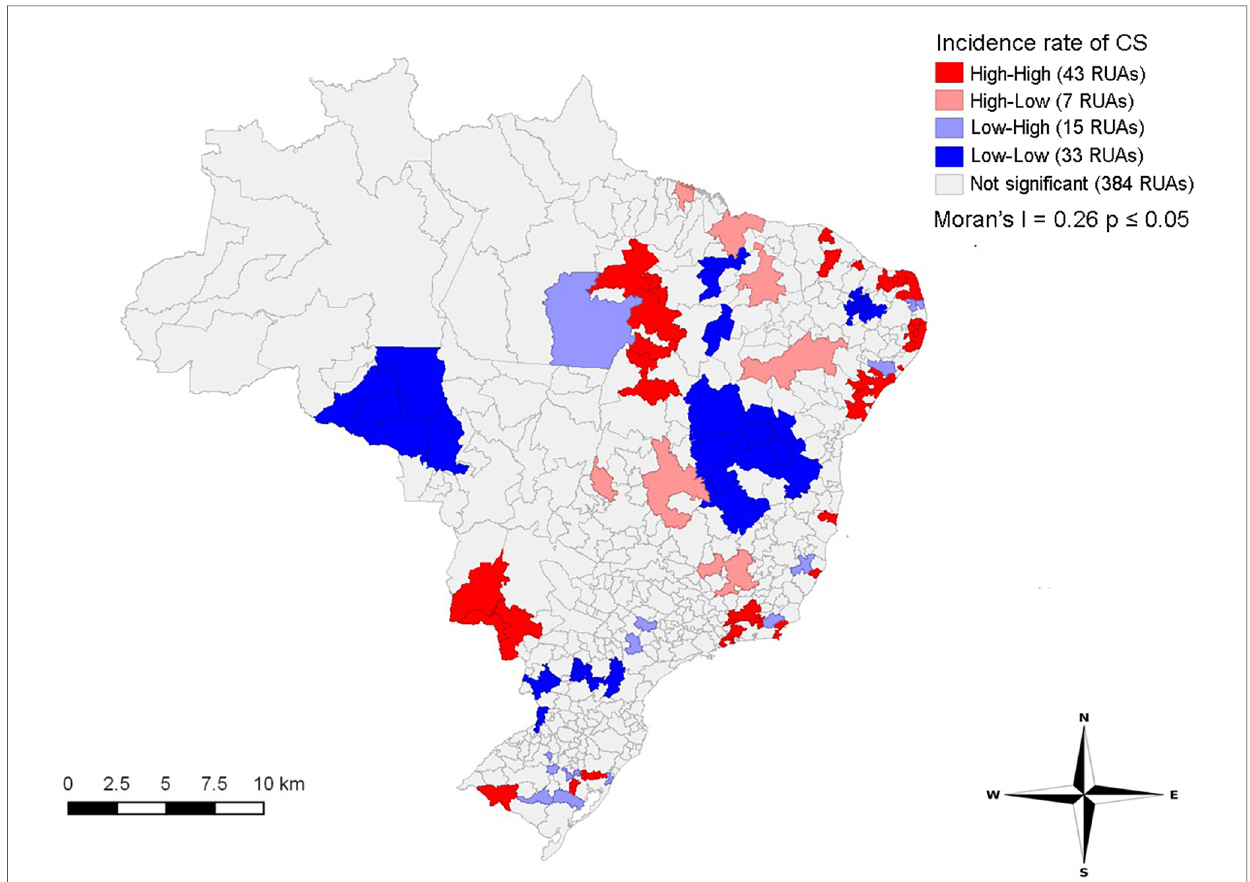
FIGURE 3 Spatial distribution of clusters (moran map) of the incidence rate of congenital syphilis in immediate regions of urban articulation in Brazil, 2008 –